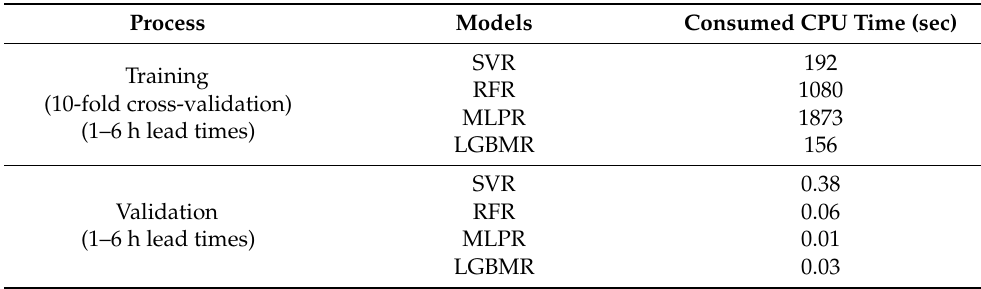
Table 9. The consumed CPU time by four models in training and validation